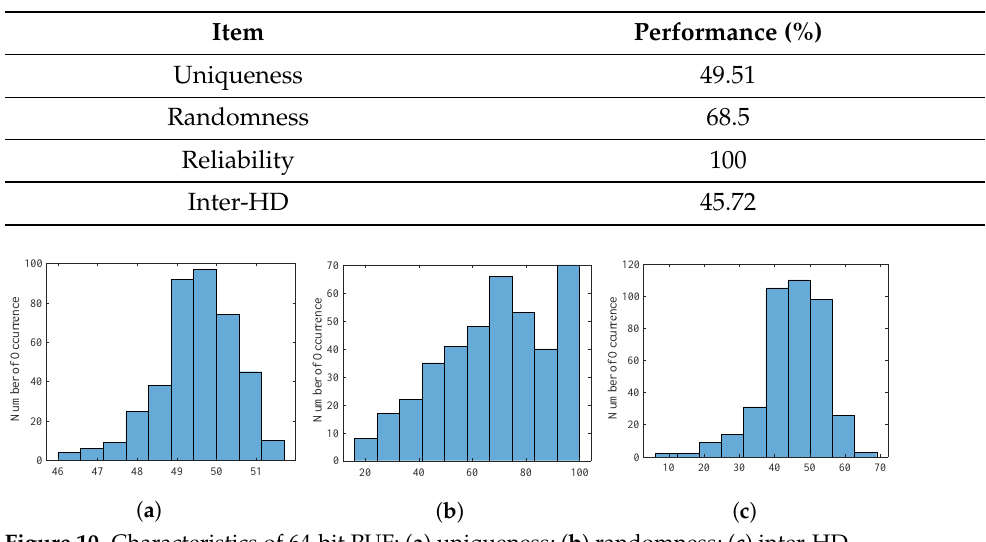
Figure 10. Characteristics of 64-bit PUF: ( a ) uniqueness; ( b ) randomness; ( c )